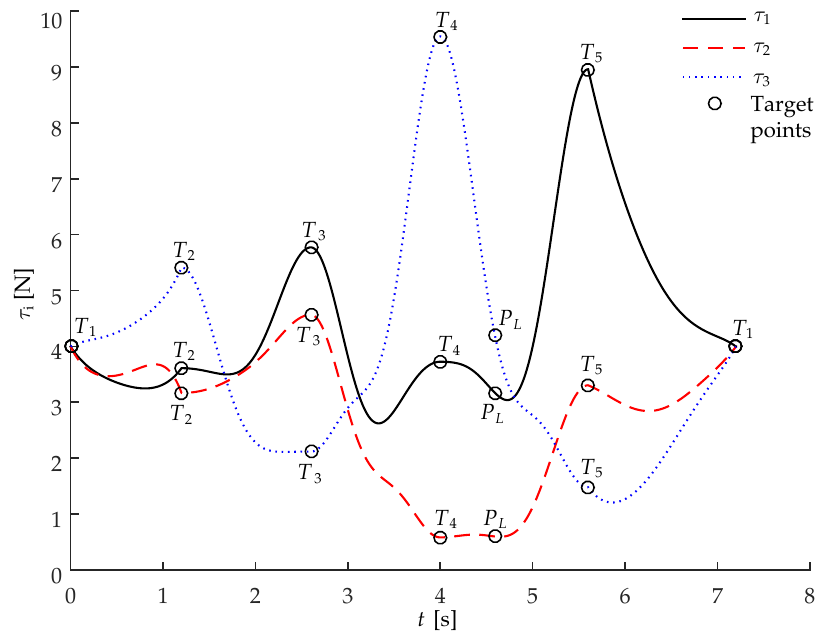
Figure 7. Plot of the cable tensions during motion for the trajectory defined by Bézier curves.